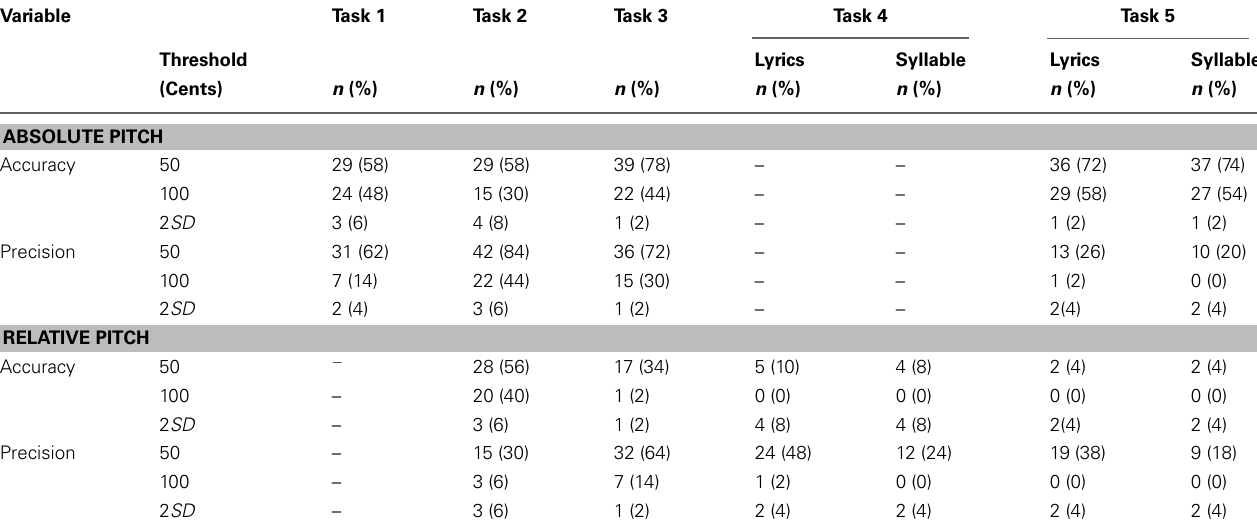
Table 4 | Number of poor-pitch singers defined according to three different criteria (accuracy or precision > 50 cents, > 100 cents, > 2 SD from the group mean) based on the results of the